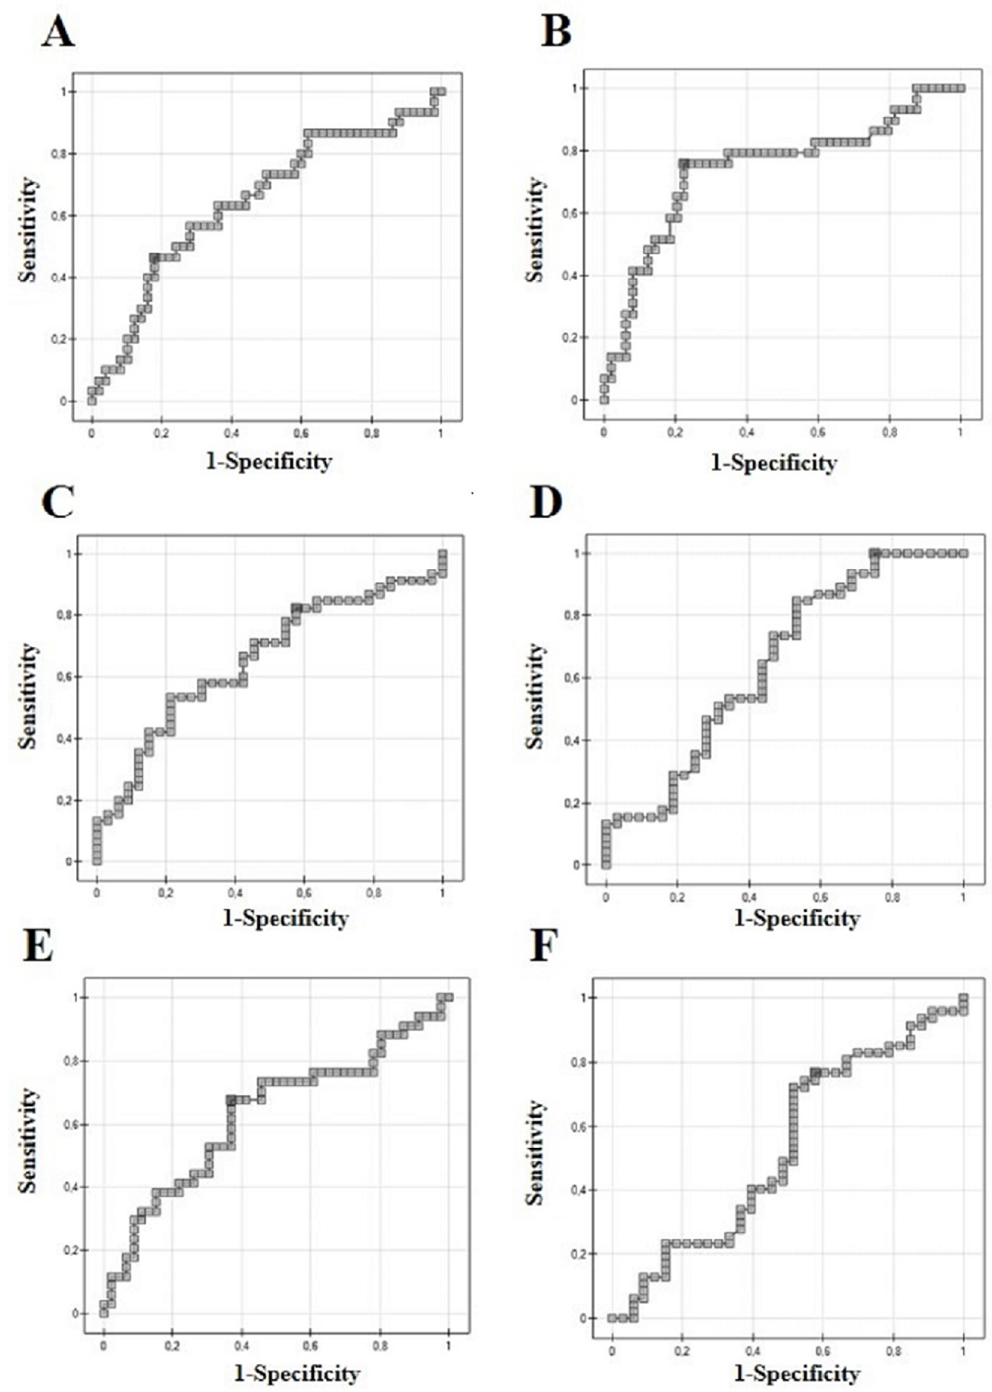
Figure 3. ROC curves for 20S proteasome in serum as diagnostic tests for ( A ) muscle-invasive tumour, ( B ) high-grade tumour, ( C ) recurrent tumour, and for UCH-L1 in serum as diagnostic tests for ( D ) muscle-invasive tumour, ( E ) high-grade tumour, ( F ) recurrent tumour.